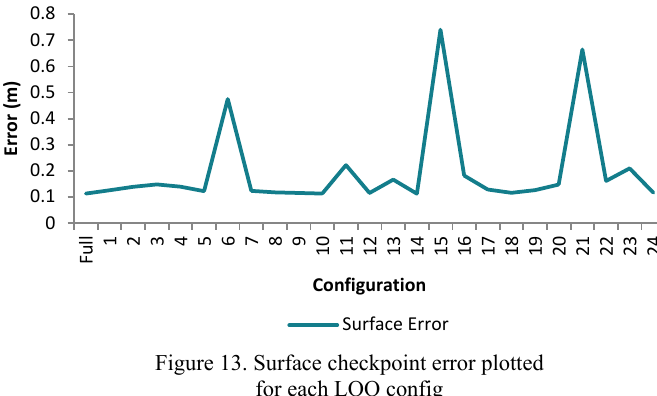
Figure 13. Surface checkpoint error plotted for each LOO